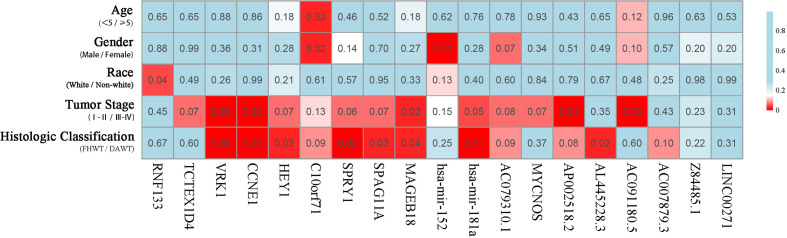
Clinical significance of prognostic RNAs in WT. Correlations between prognostic RNAs and clinical factors. The numbers and brightness of each cell indicate the P-value.